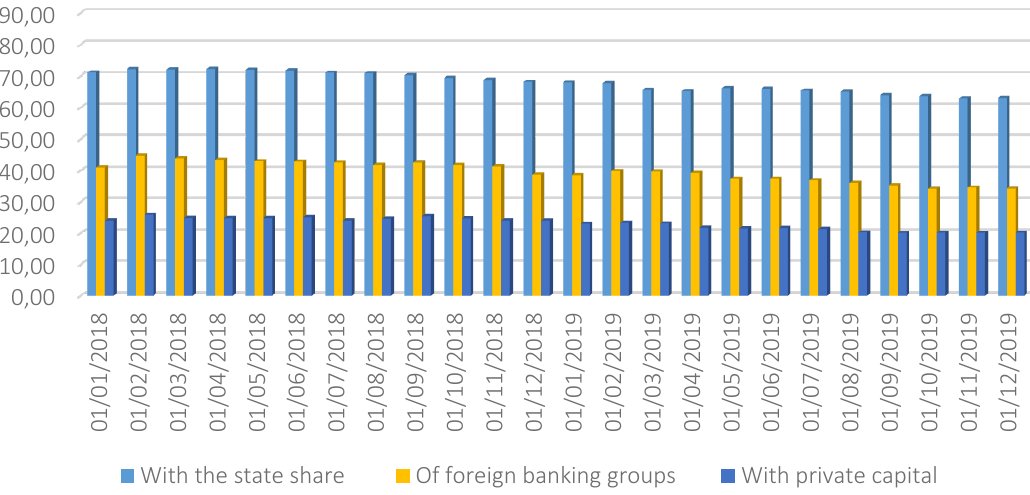
Figure 12. Dynamics of NPLs in terms of bank groups on the basis of